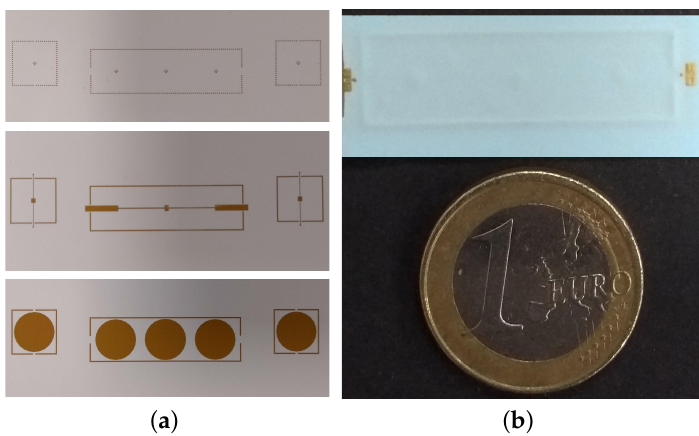
Figure 11. ( a ) Photograph of some layers of the LTCC stack-up (i.e., from top to bottom, via holes punching and after printing the coupling and capacitive patch, respectively). The resonator layout is also visible at the sides of the photograph; ( b ) Photograph of three-pole BPF prototype.